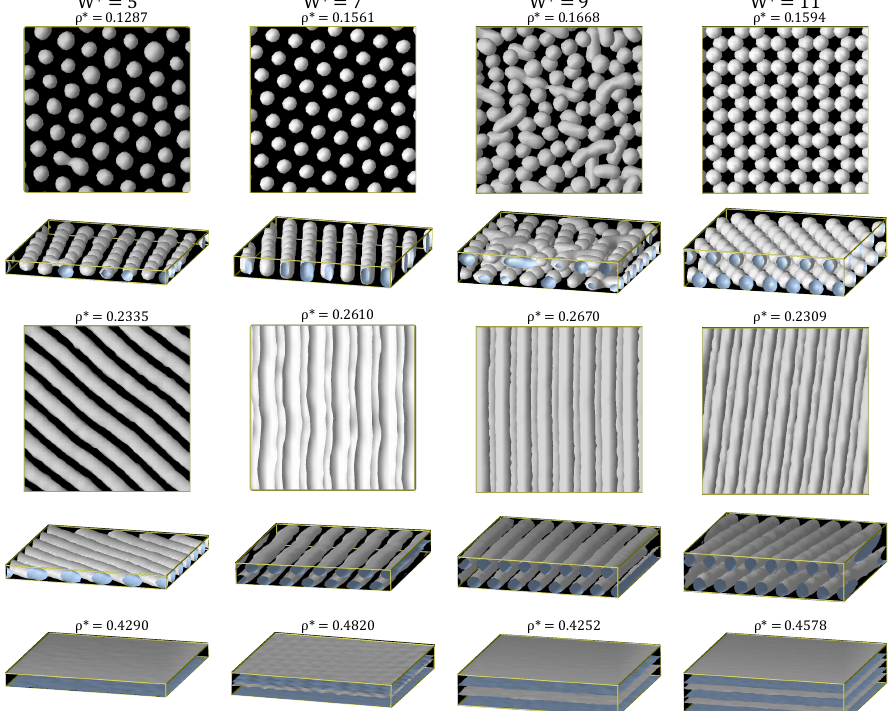
= 0.30 for all the ordered microphases obtained at different Figure 3. Local density isosurfaces ρ ∗ iso slit widths, W ∗ . Note that the density chosen for the isosurfaces is somewhat lower than that in our previous work on SALR systems modelled with the square-well linear model (in which we = 0.40) [25–27]. The reason for this new choice is that the clusters obtained with the chose ρ ∗ iso Lennard-Jones plus Yukawa model used in this work are appreciably smaller [17]. Two views are presented for cluster-crystal and hexagonal phases and one for the lamellar phase. The number densities in reduced units, ρ ∗ , are specified and the temperature is T ∗ =